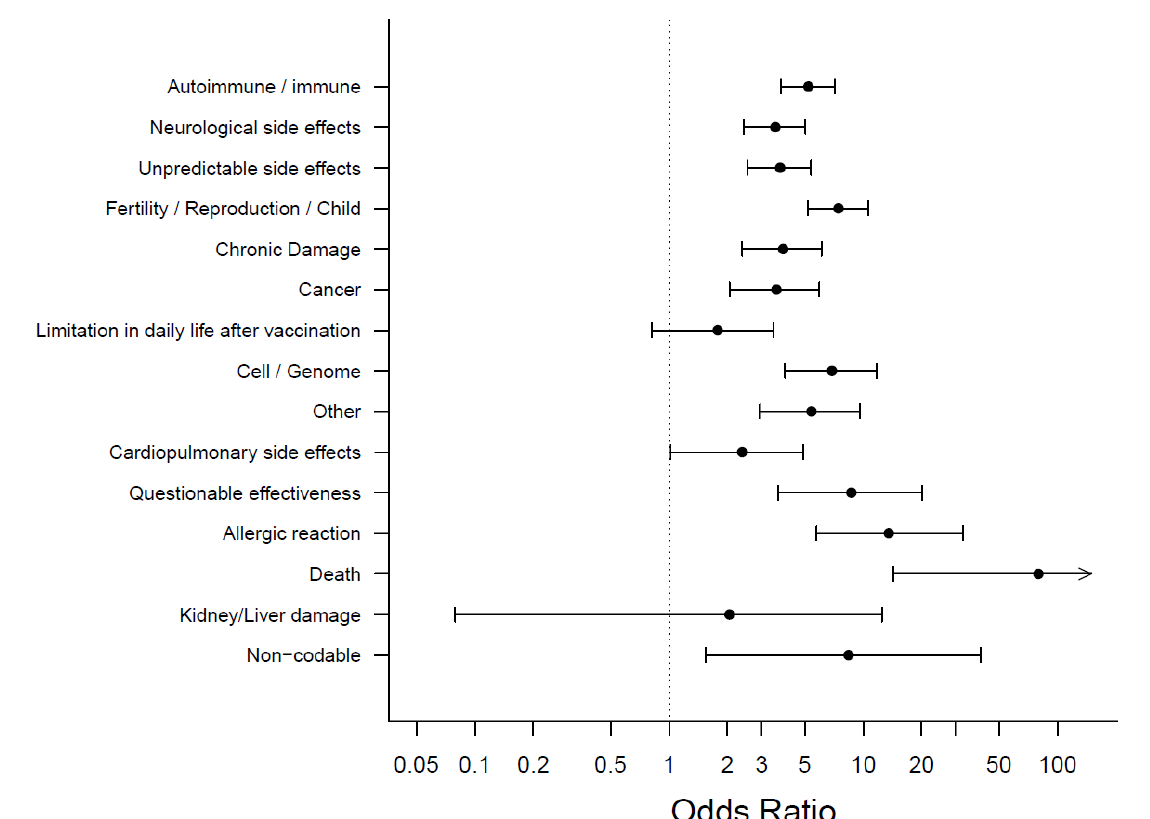
Figure 7. Feared long-term side effects and Odds Ratios for COVID-19 vaccination hesitancy, with categories arranged by frequency, most frequent on top. Upper limit of the 95% confidence interval for “death” is 2006.